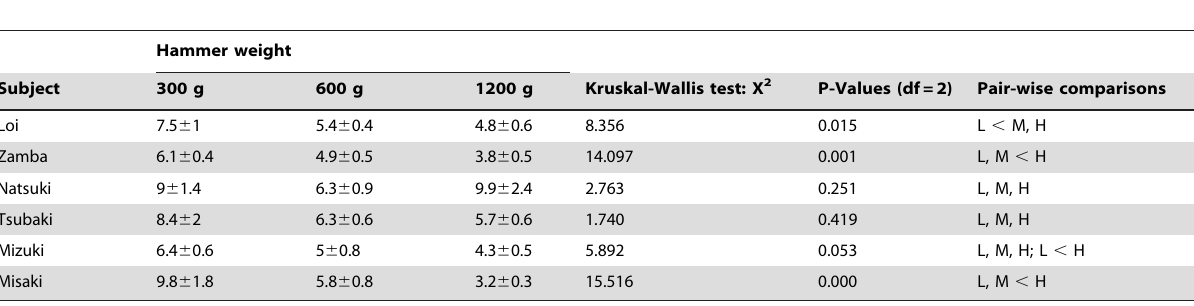
Table 5. Average time ( 6 SE) to solution for all subjects as a function of hammer weight.